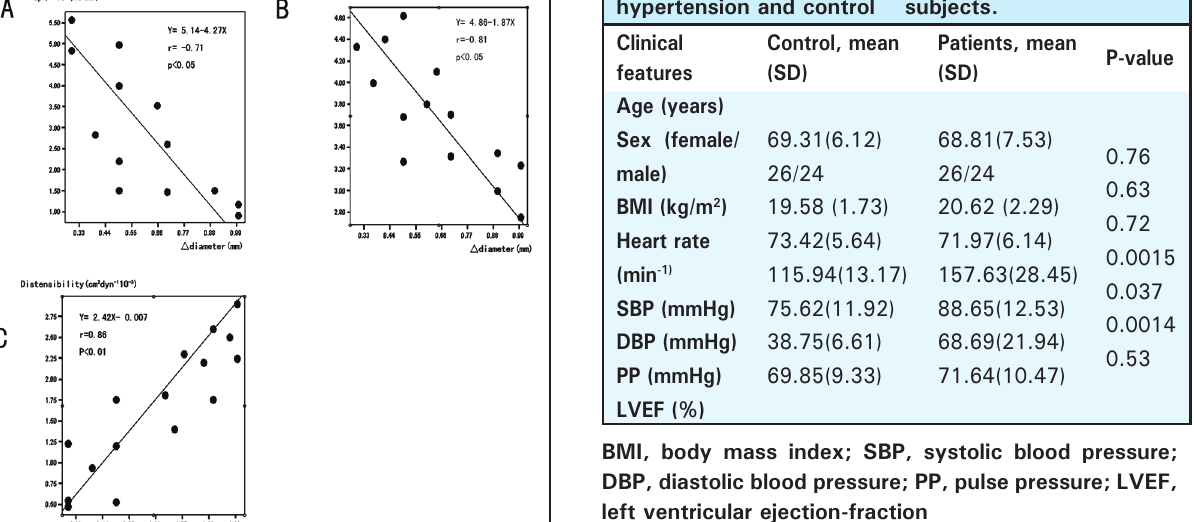
Table 1. Clinical characteristics of patients